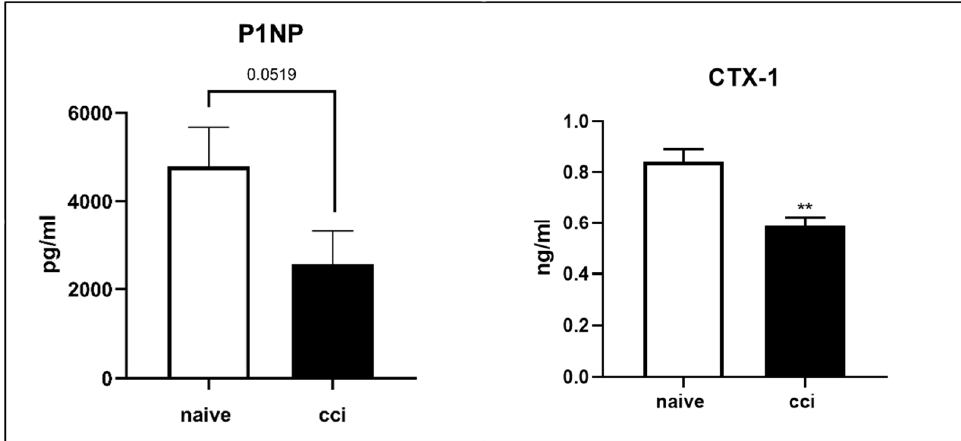
Figure 15. Serum markers P1NP and CTX-1 levels 4 weeks after surgery. CTX-1 serum levels were lower in CCI rats compared to those of naïve animals. P1NP showed a trend toward reduction in rats that underwent surgery. The results are expressed as mean ± S.E.M. **: p < 0.01 vs.